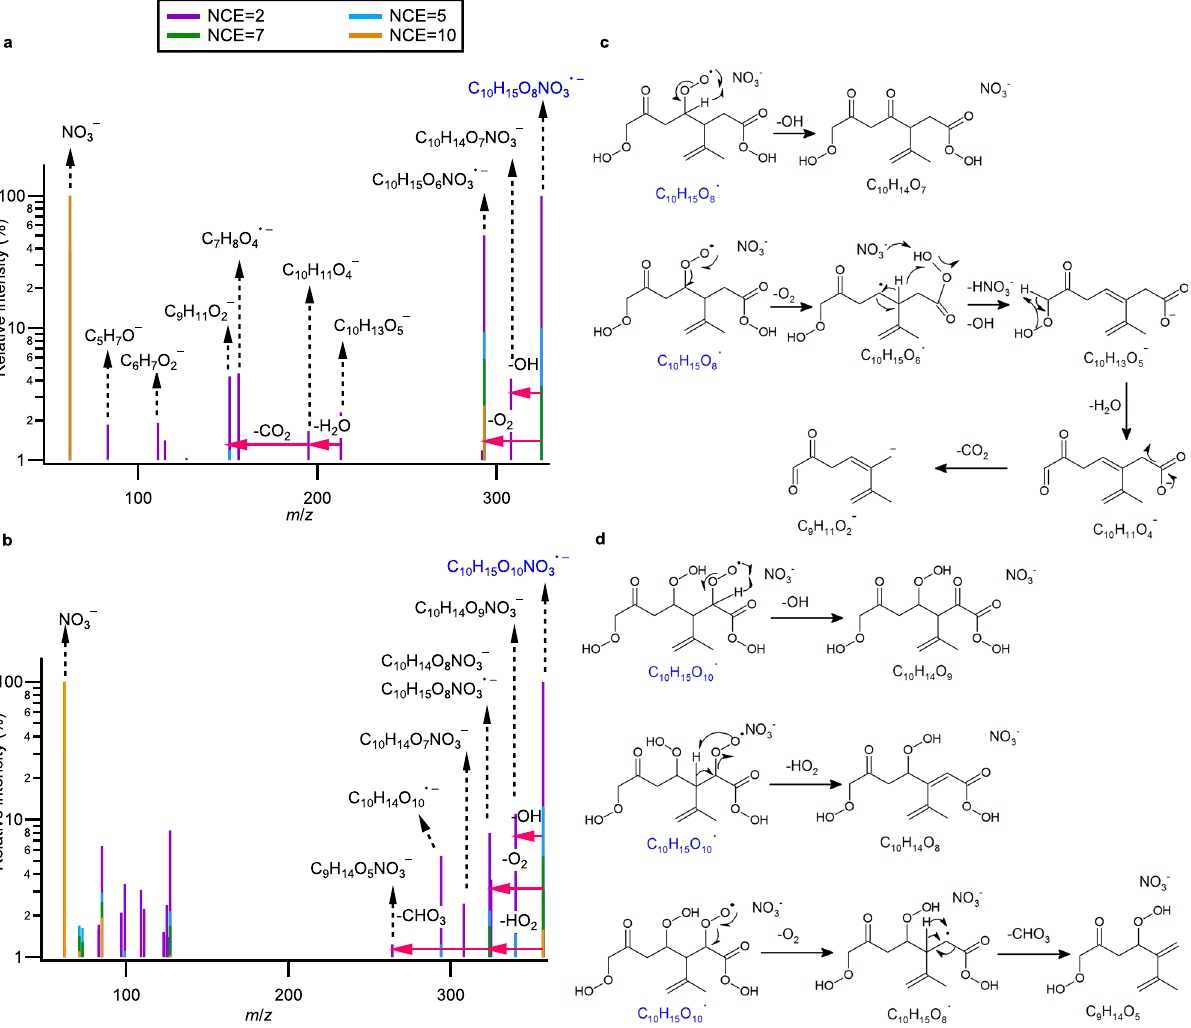
Fig. 3 MS/MS spectra of two limonene ozonolysis RO 2 radicals at various NCE (2 – 10). a MS/MS spectra of C 10 H 15 O 8 NO 3 (cid:129) – . b MS/MS spectra of C 10 H 15 O 10 NO 3 (cid:129) – . c MS/MS fragmentation routes to product ions, C 10 H 14 O 7 NO 3 – and C 9 H 11 O 2 – from the A2 structure of C 10 H 15 O 8 NO 3 (cid:129) – as depicted in Fig. 2. d MS/MS fragmentation route to product ions, C 10 H 14 O 9 NO 3 – , C 10 H 14 O 8 NO 3 – , and C 9 H 14 O 5 NO 3 – , from the structure B2-1 of C 10 H 15 O 10 NO 3 (cid:129) – as depicted in Supplementary Fig. 7. The parent radical anions are highlighted in